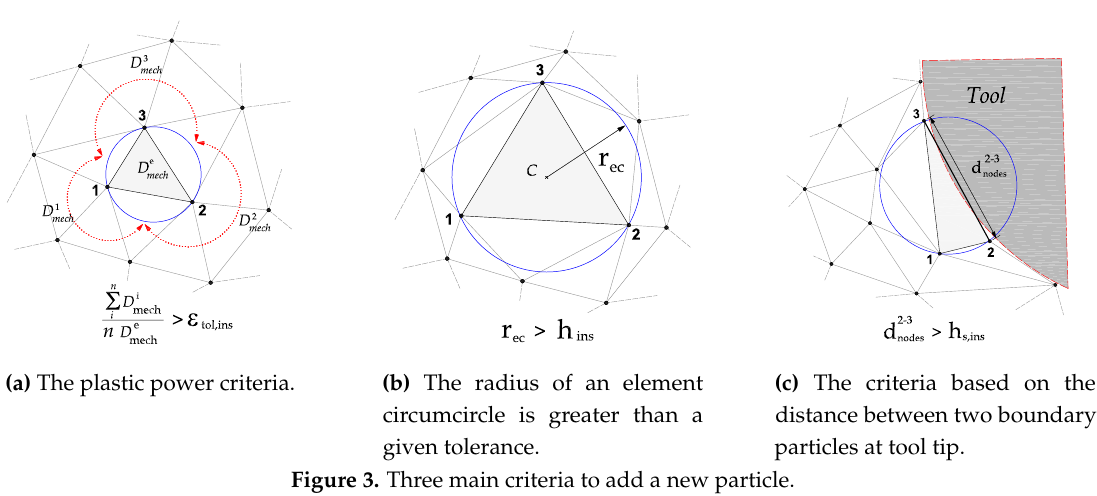
Figure 3. Three main criteria to add a new